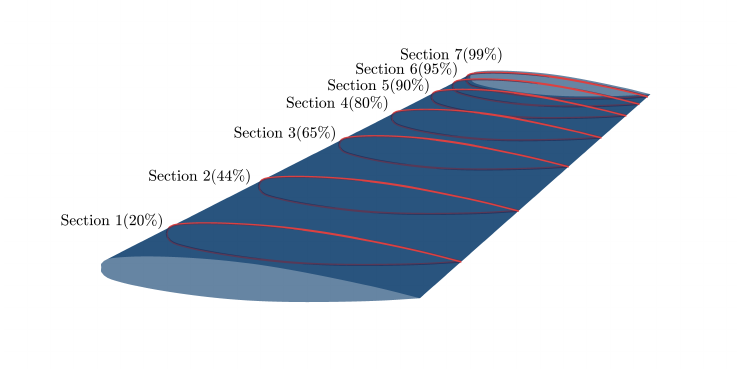
Figure A3. ONERA M6 pressure coefficient measurements spanwise sections.